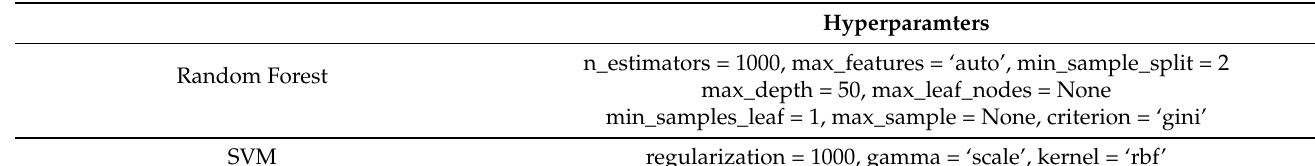
Table 6. Hyperparameters of Machine Learning